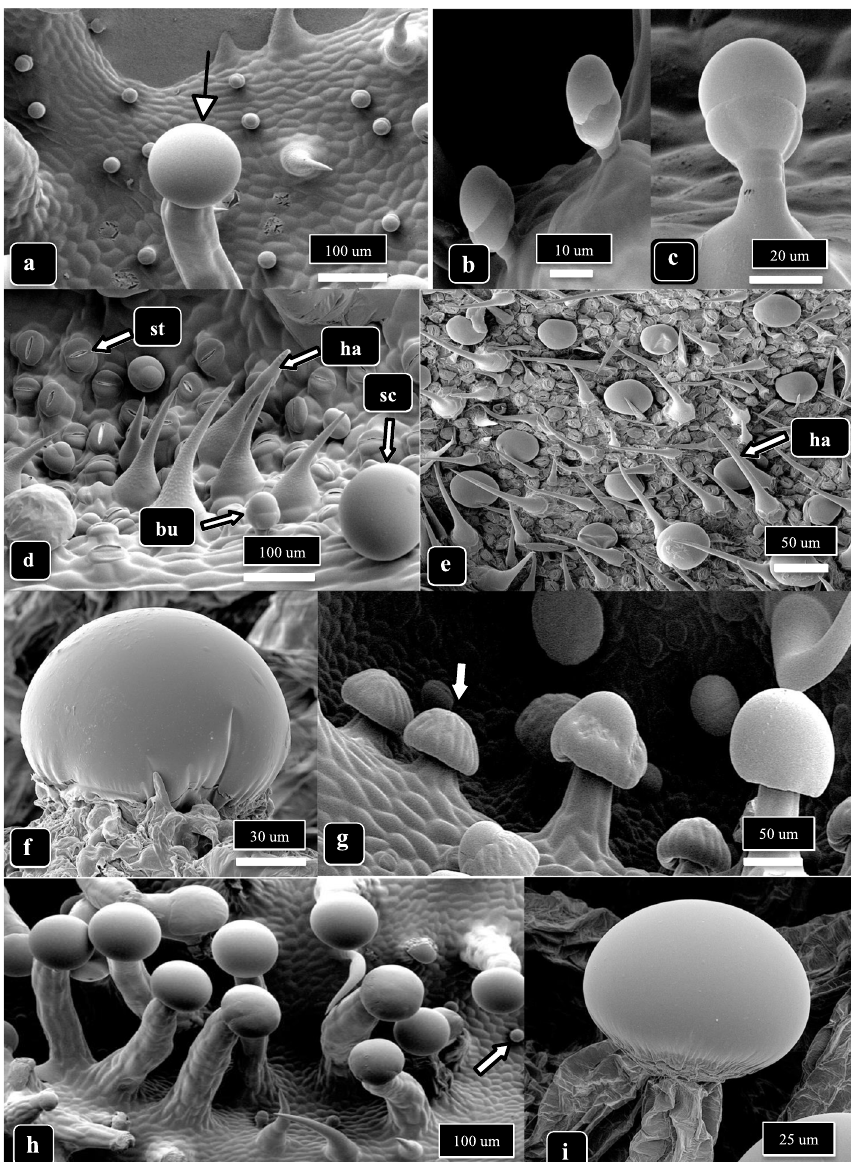
Fig. 2 The different trichome types on Cannabis bract tissues observed in this study. All images are obtained from strain MD, lower bract surface, at 3 and 6 weeks of inflorescence development. a A stalked capitate trichome in the foreground (arrow) compared with small bulbous trichomes in the background. b , c Bulbous trichomes formed on short pedicels. d Nonglandular trichomes (ha) formed next to a bulbous (bu) and a sessile-capitate trichome (sc). In the background, abundant stomata (st) can be seen on raised epidermal cells. e Nonglandular hairs (ha) interspersed with sessile-capitate trichomes on a young bract. f Magnified view of a sessile-capitate trichome with fully formed head surrounded by a cuticle. g Presecretory sessile-capitate (arrow) and mature stalked-capitate trichomes with fully formed heads adjacent to one another. h Mature stalked-capitate trichomes formed in large numbers. Note the presence of small bulbous trichomes (arrow) and nonglandular trichomes in the background. i Magnified view of the head of a stalked-capitate trichome with fully formed cuticle surrounding the